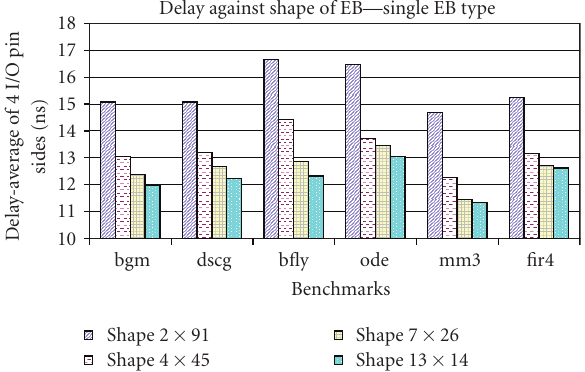
Figure 8: Delay against various EBs positions for single EB type FPGA, as defined in Figure